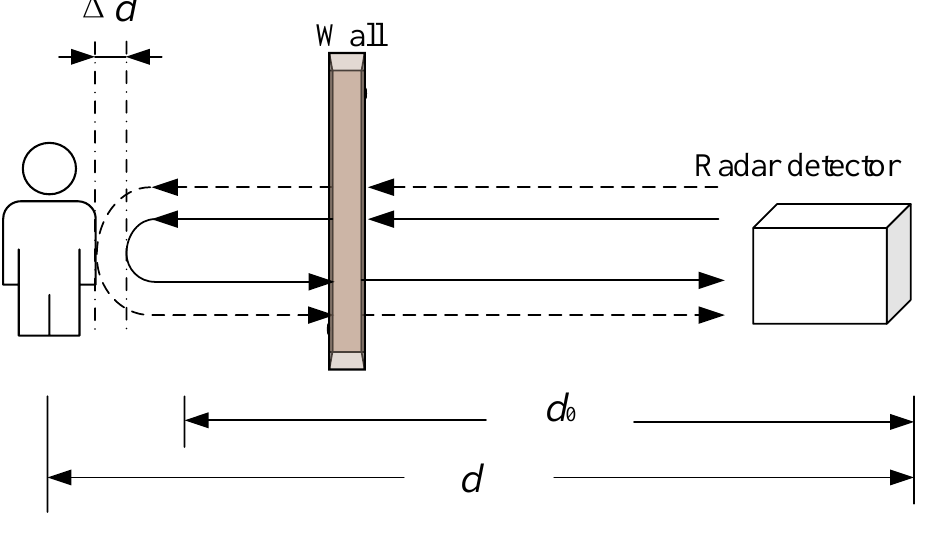
Figure 1. Detection principle.